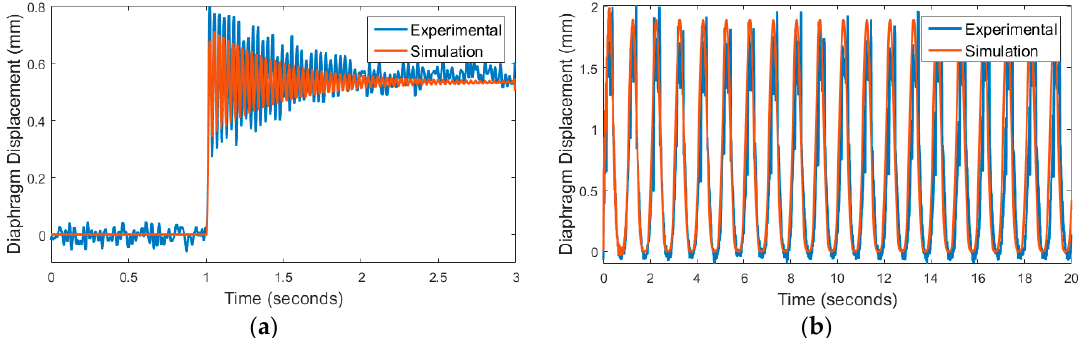
Figure 3. Validation Results: ( a ) T2 (RMS = 0.069 mm); ( b ) T3 (RMS = 0.35